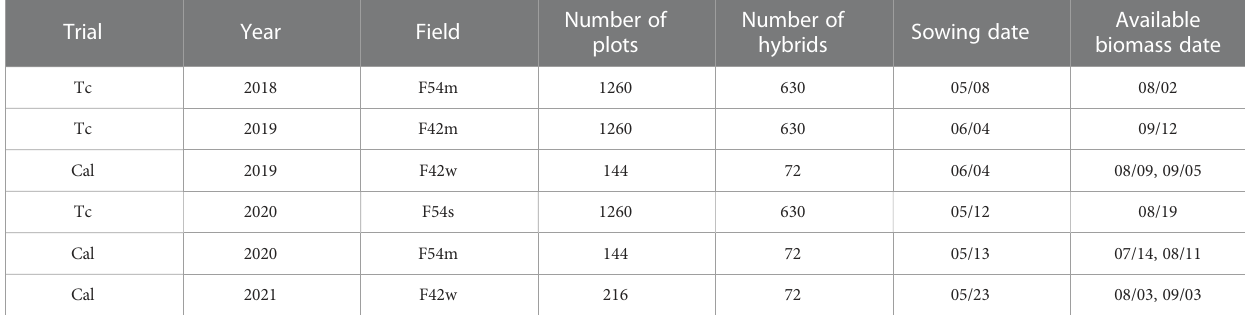
TABLE 1 Multi-year fi eld survey